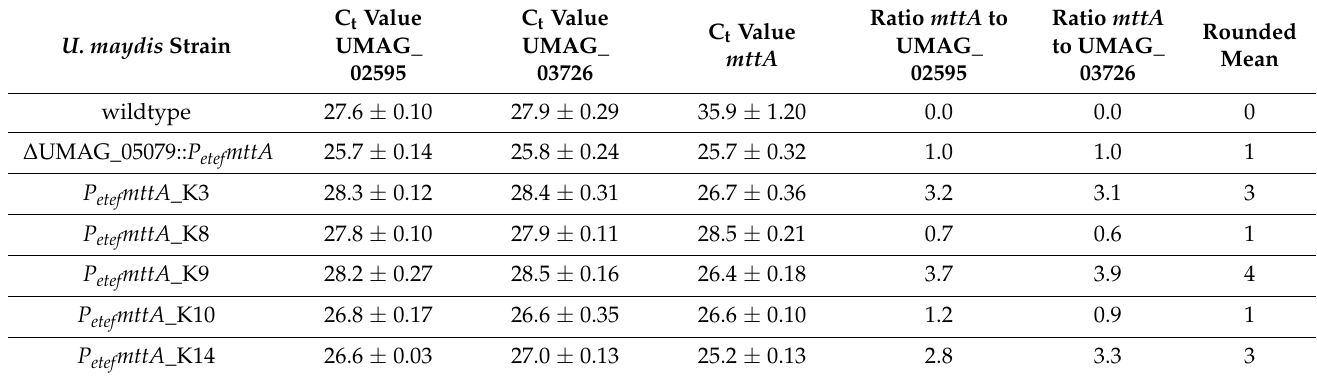
Table 4. Determination of P etef mttA copy number in five U. maydis MB215 ∆ cyp3 ∆ MEL ∆ UA ∆ dgat ∆ P ria1 :: P etef ∆ fuz7 P etef mttA transformants by quantitative polymerase chain reaction (PCR). ± values indicate the standard error of the mean ( n = 3).